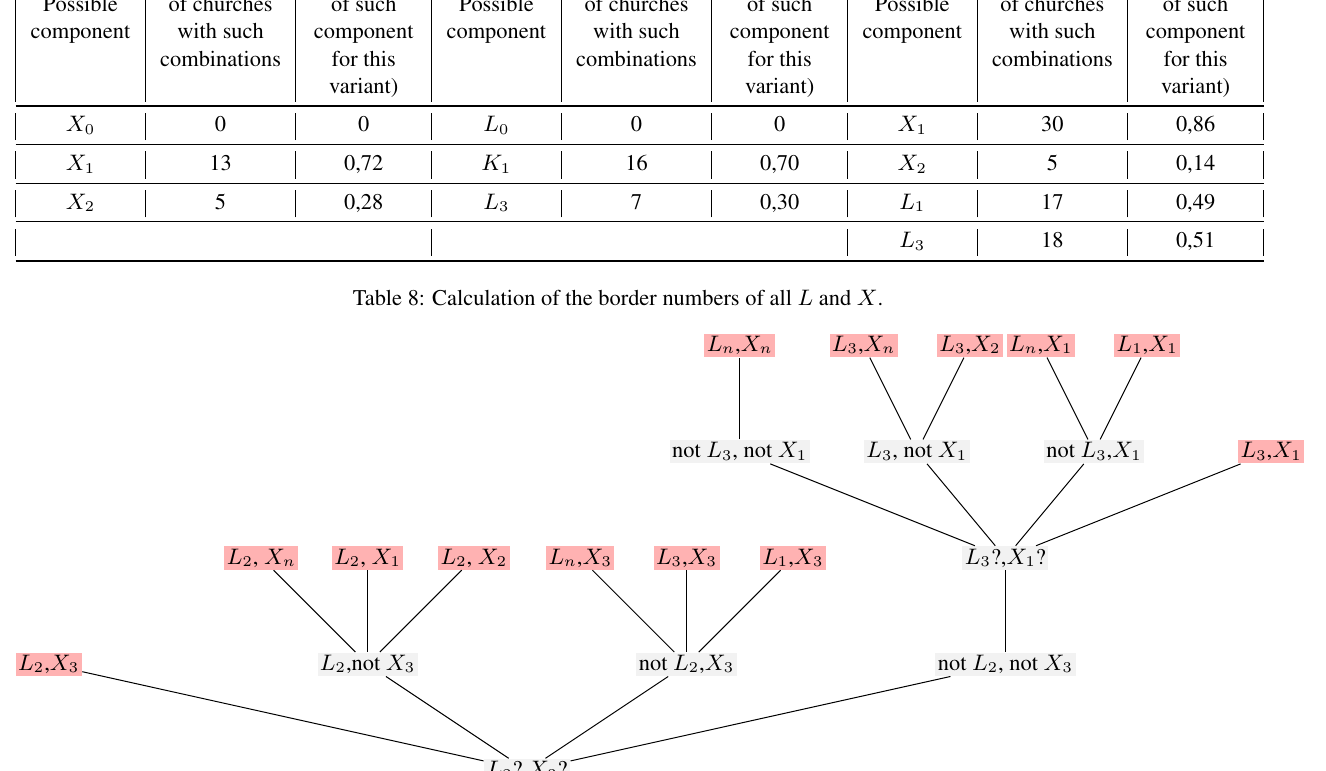
L 2 ?, X 3 ? Table 9: Searchgraph of the example. The leaves of the graph in light red color mark final classifications